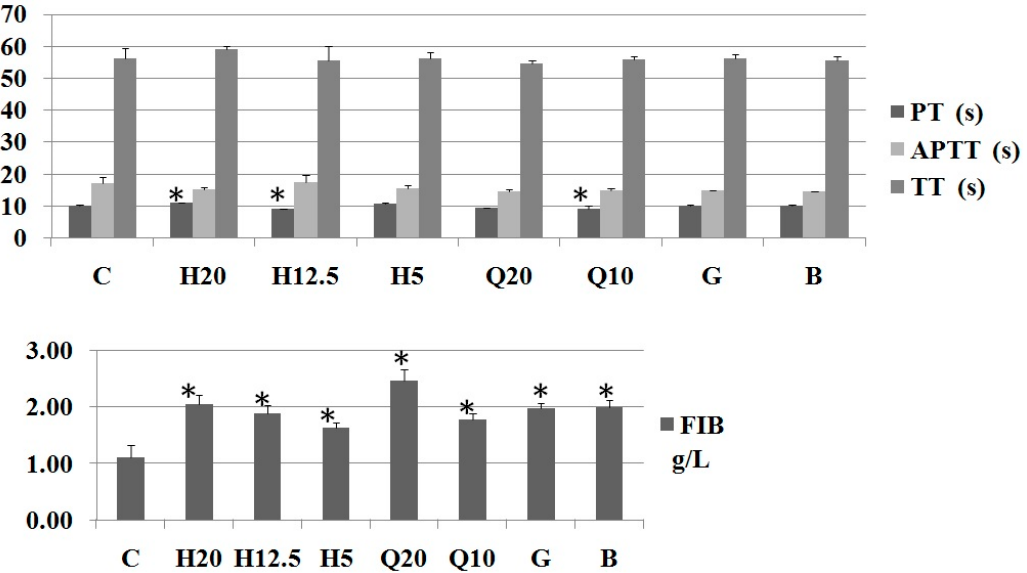
Figure 3. Effects on the four blood coagulation parameters of PS H and PF saponin extract in rats( n =